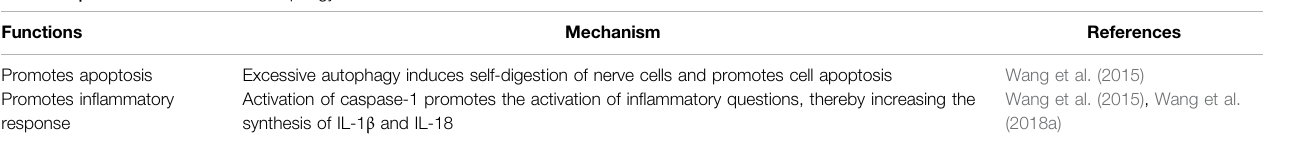
TABLE 2 | The harmful effects of autophagy on